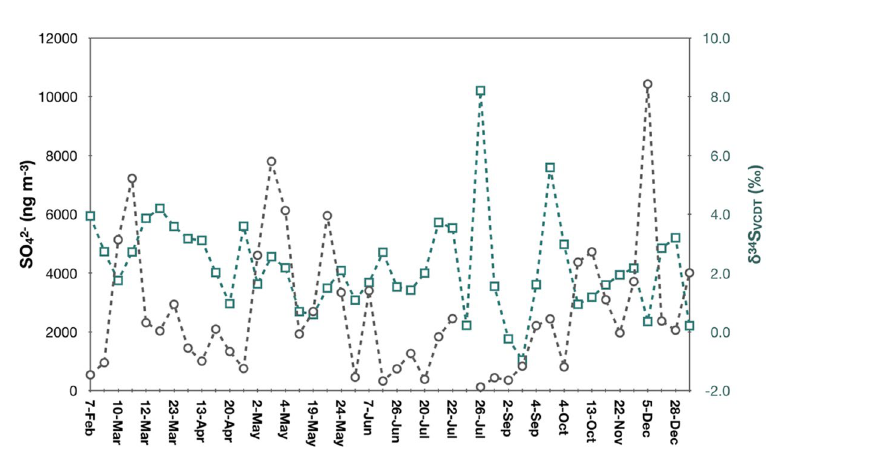
Figure 3. Time series of δ 34 S and SO 42 −